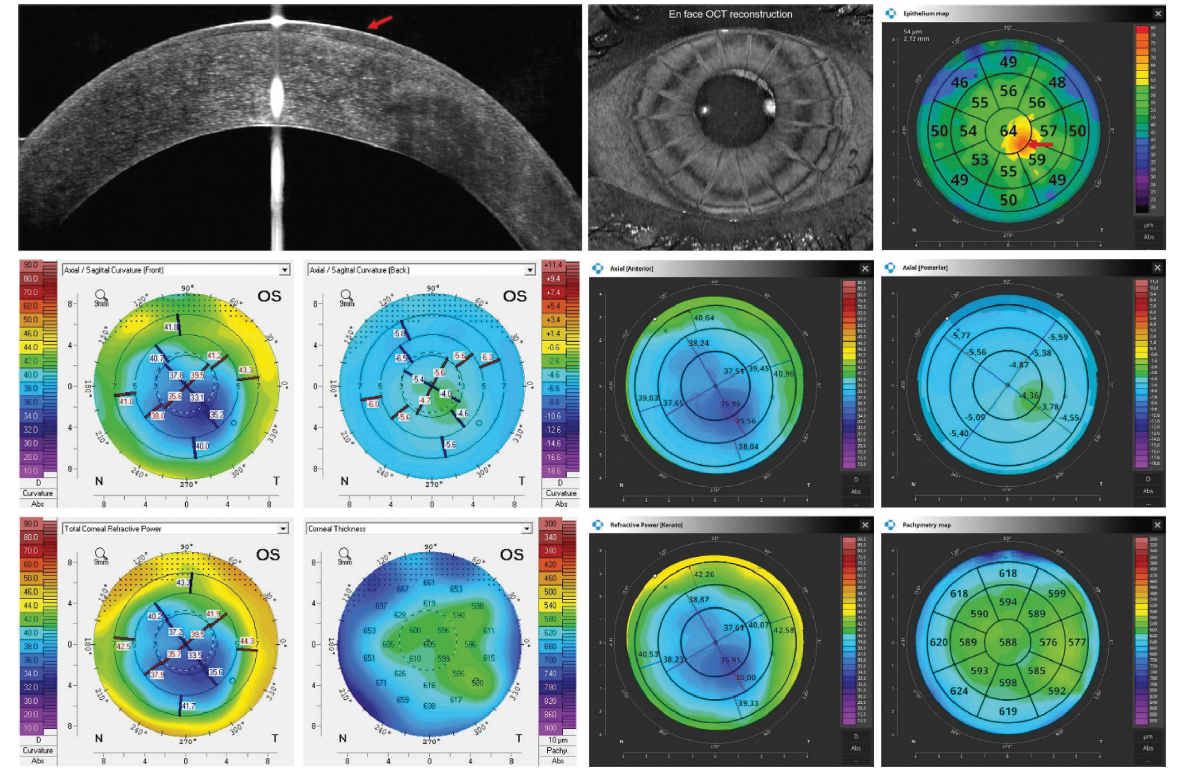
Figure 6: Postradial keratotomy eye. ETM shows a small paracentral island of increased epithelial thickness (red arrow). Topography maps show an area of reduced curvature of the posterior corneal surface at this location. Also, a flattening of the anterior surface of the cornea can be observed. The measurements performed with Pentacam have a white background, and the ones performed with REVO NX have a black background. The K1, K2, and astigmatism values for the anterior surface of the cornea obtained using Pentacam are 35.5D, 37.5D, and 1.9D, respectively, while the values obtained using REVO NX are 35.6D, 37.5 D, and 1.9 D, respectively. The values of analogous parameters for the posterior corneal surface from Pentacam are − 4.5 D, − 5.0D, and 0.5 D and the values from the REVO NX are − 4.2D, − 5.0D, and